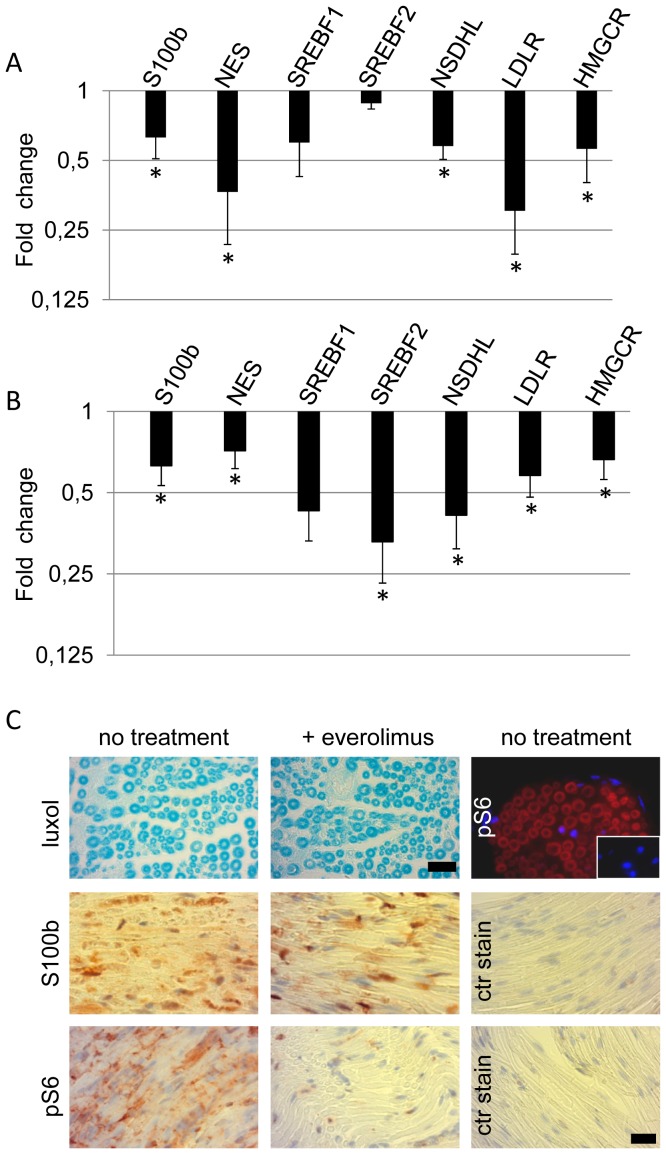
Rapamycin treatment down-regulates Schwann cell marker expression in differentiated human AFS cells and in sciatic nerves from juvenile mice.(A) Quantitative RT-PCR of cDNA derived from AFS cells differentiated towards Schwann cells for 15 days with and without rapamycin was performed to assess Schwann cell marker expression. Results are shown as fold change of respective gene expression from rapamycin-treated cells compared to control treated cells. (B) Sciatic nerves were isolated from everolimus- or control-treated mice and cDNA generated thereof was assessed for Schwann cell marker expression. Results are shown as fold change of respective gene expression from everolimus-treated mice compared to control-treated mice. The results are expressed as means ± SEM of three independent experiments. P<0.05 for * vs control treated cells or animals. (C) Sciatic nerves from untreated or treated mice were subjected to Luxol fast blue staining and immunohistochemical staining for S100b and S6 phosphorylation was performed (stained in red, nuclei in blue). Panel in upper right shows control treated sciatic nerve tissue stained for active S6 protein (red) and nuclei (blue), insert shows control antibody staining. Scale bar represents 20 µm.